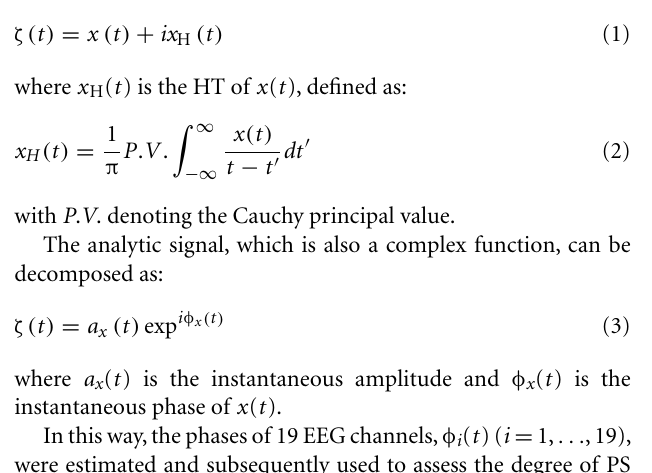
displayed and recorded at a sampling rate of 128 Hz for further at 50 Hz was used for the elimination of power line